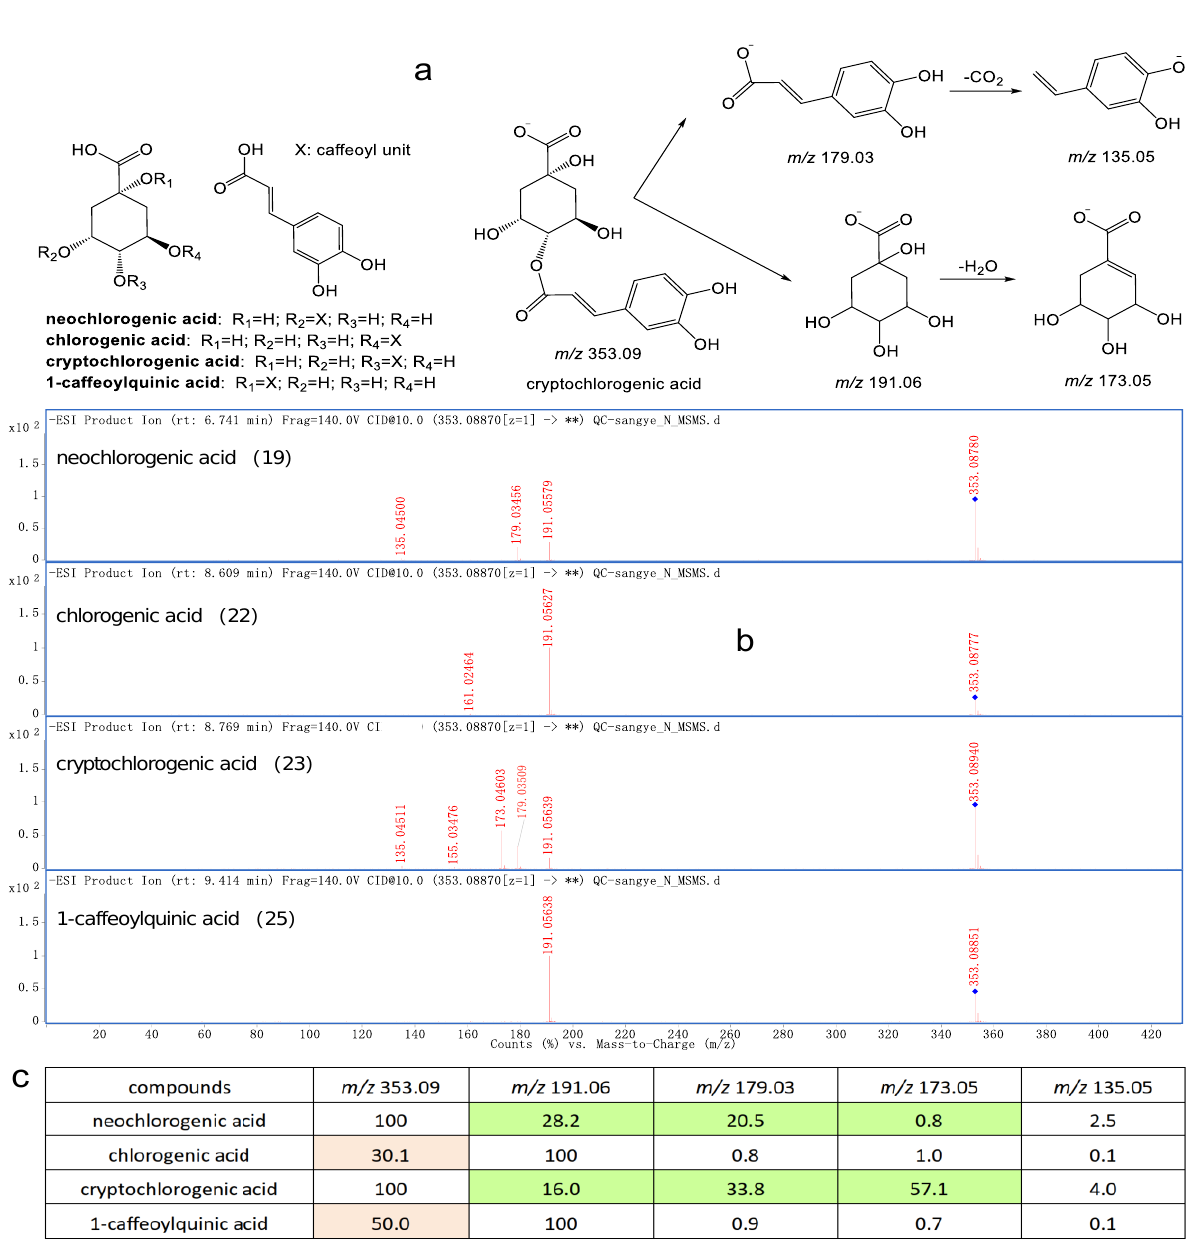
Figure 4. Fragmentation patterns ( a ), MS/MS spectrum ( b ) and ion ratios of four chlorogenic acid isomers ( c ).